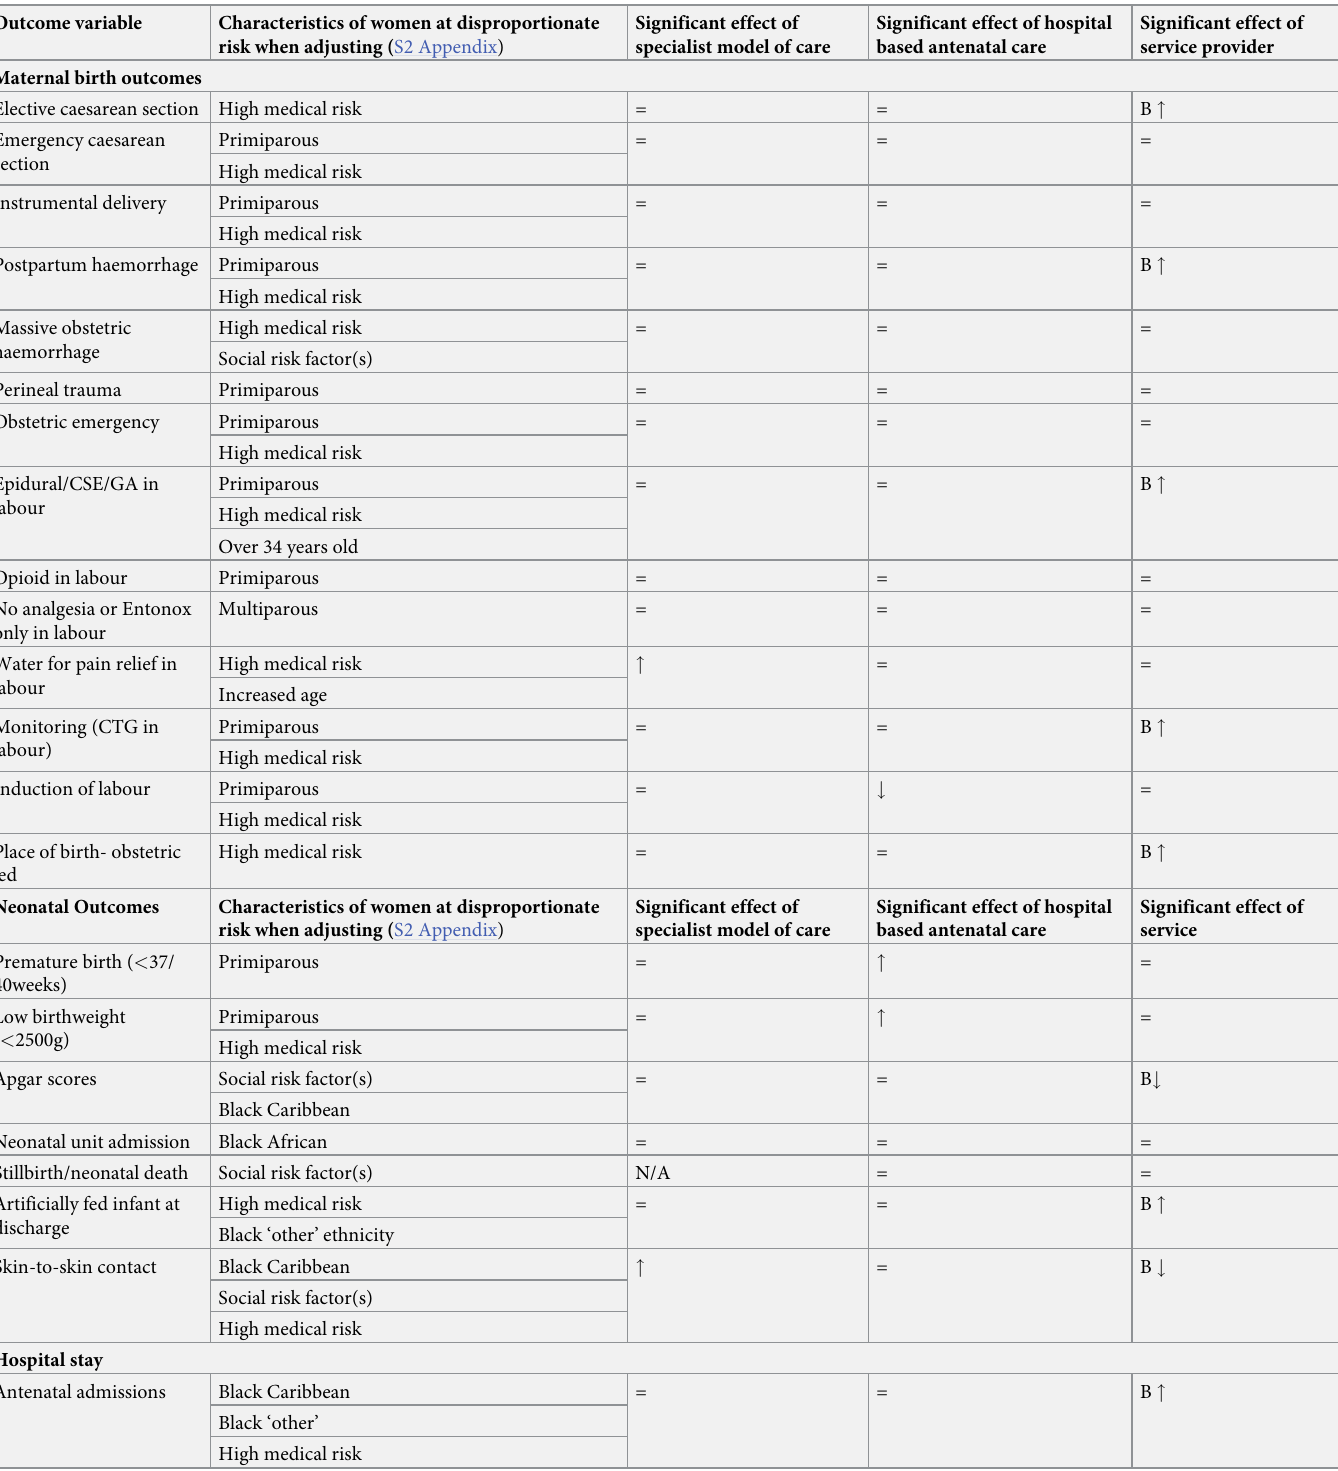
Table 16. Overview of outcomes. Outcome variable Characteristics of women at disproportionate risk when adjusting ( S2 Appendix)